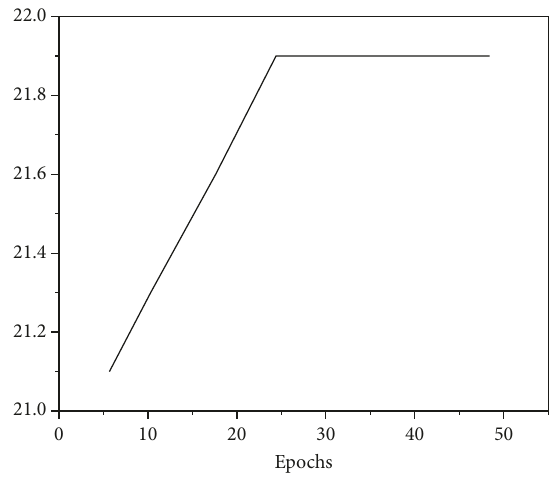
Figure 4: Average PSNR of 50 training cycles. Table 3: Objective evaluation indexes of different algorithms on real low-illumination images.